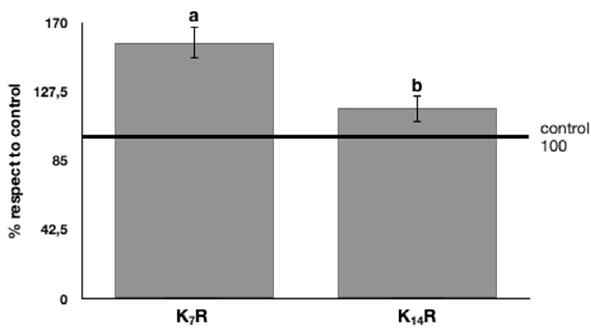
Figure 5. Effects of rooibos kombuchas on L929 cell proliferation; data, expressed as % of control, represent mean ± 2 SEM of three independent experiments. Statistical analysis of differences was carried out by two-way ANOVA followed by Fisher’s LSD as post-hoc test. Different letters represent statistical significance ( p ≤ 0.05).